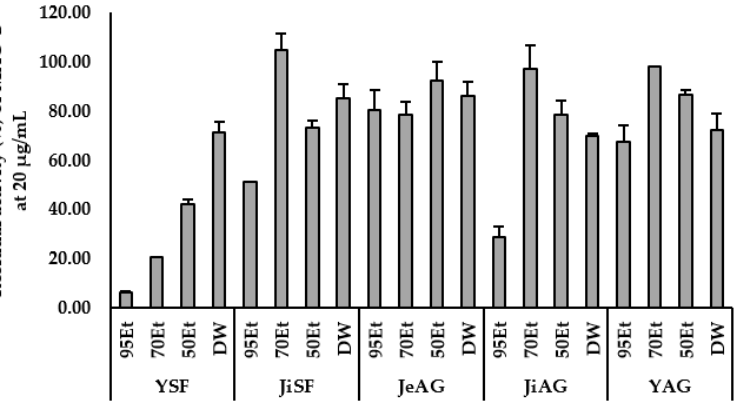
Figure 3. Inhibition of MAO-B by the extracts. Activity of MAO-B was observed as the procedure described in the ‘Materials and Methods’ section, by adding the extract ( 20 μg/mL ) to the reaction mixture containing 0.30 mM of benzylamine.